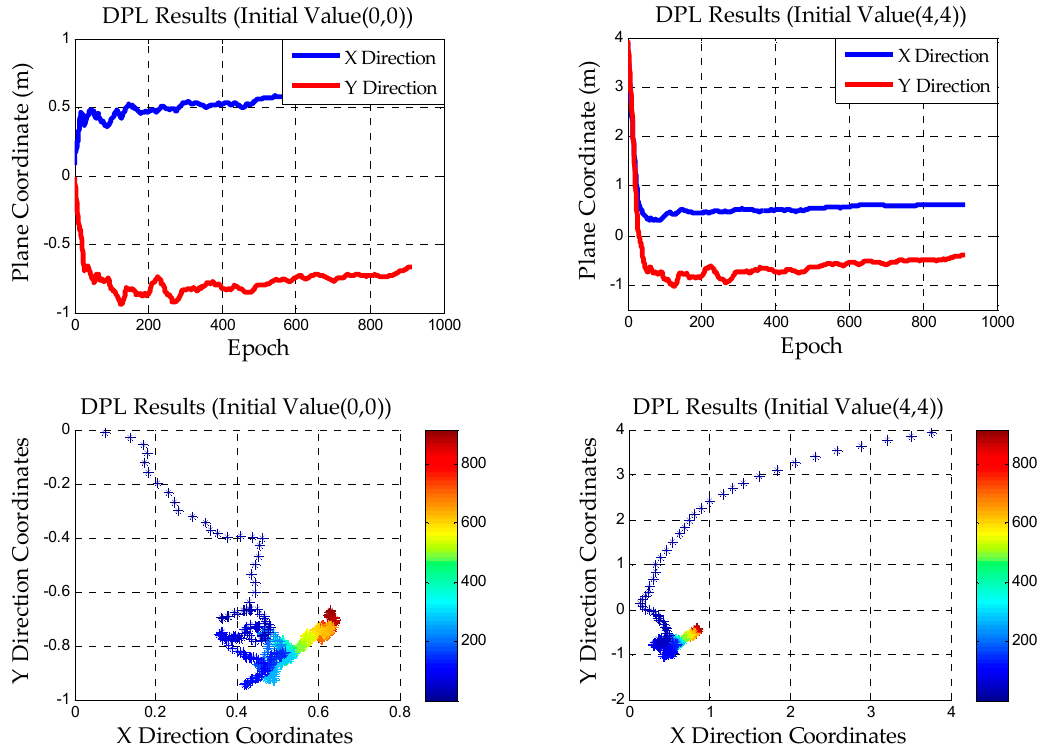
Figure 6. The results of DPL in the short baseline static experiment.